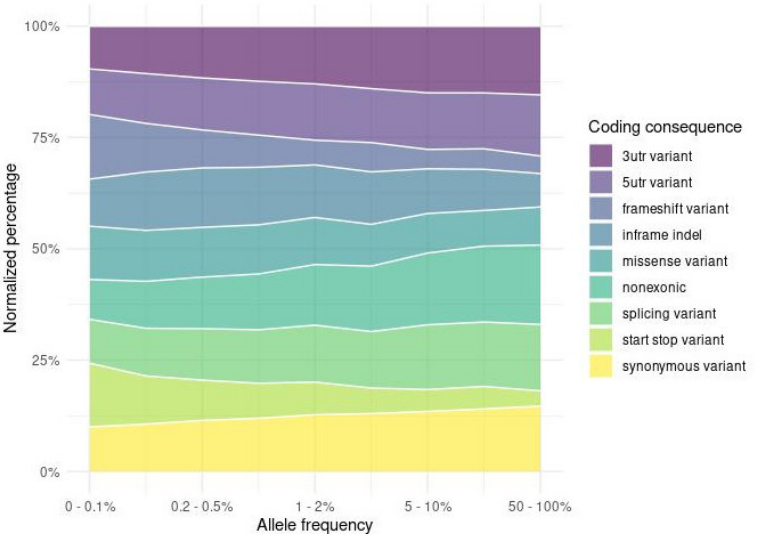
Figure 4. Comparison of exonic and non-exonic variant consequences across the allele frequency spectrum. As expected, variants with the largest impact on the encoded protein (e.g., start–stop, frameshift) were depleted among the common and enriched among the rare variation. On the opposite side, the relative abundance levels of non-exonic, UTR, and synonymous variants, which do not alter the amino acid sequence, increased with increasing variant population frequency.